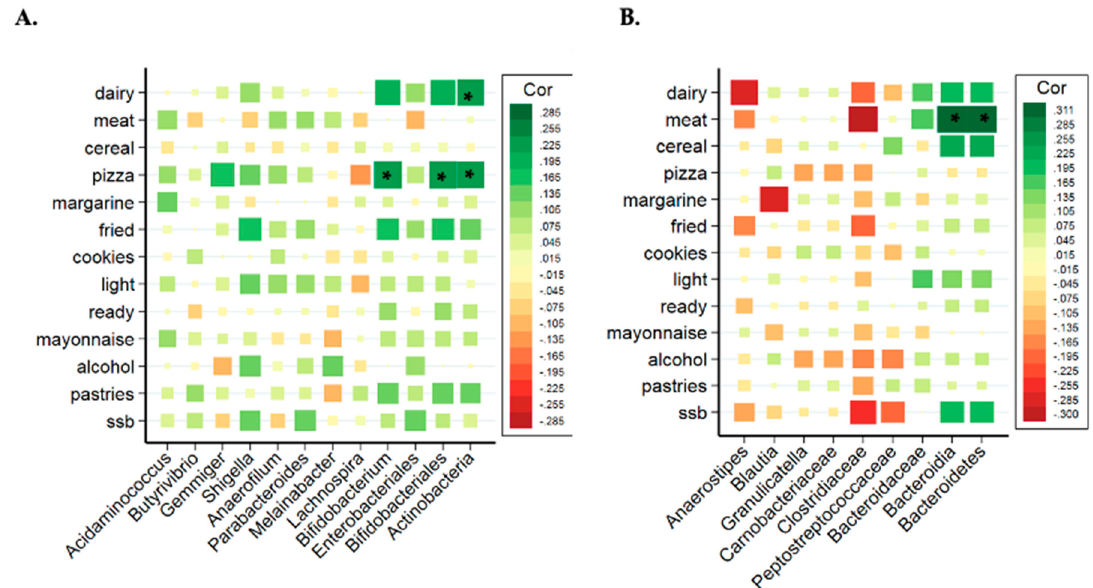
Figure 2. Correlation analysis of the significant bacterial taxa related to different types of UPFs in women ( A ) and in men ( B ). Spearman correlation coefficients and the corresponding P values were calculated based on comparisons of the relative abundance from genus to phylum and the consumption per day of UPF groups. * Adjusted p < 0.05. Correction for multiple comparisons used the false discovery rate (FDR; threshold of 0.05). Industrially processed dairy consumption includes cream, smoothies, milk drinks with or without flavors, flavored yogurts, custard, puddings and ice-creams; industrially processed meat consumption includes ham, smoked bacon, chorizo, mortadella, salami, sausage, hamburger, pate, spicy sausage, black pudding mortadella and meatballs; cookie consumption includes cookies and chocolate cookies; ready-to-eat food consumption includes instant soups and creams, instant pasta, croquettes and powdered soups and purees; pastries consumption: packaged buns, pre-prepared pies, prepared cakes, muffins, doughnuts, croissant or other business-type pastries, churros, chocolates and candies, nougat and